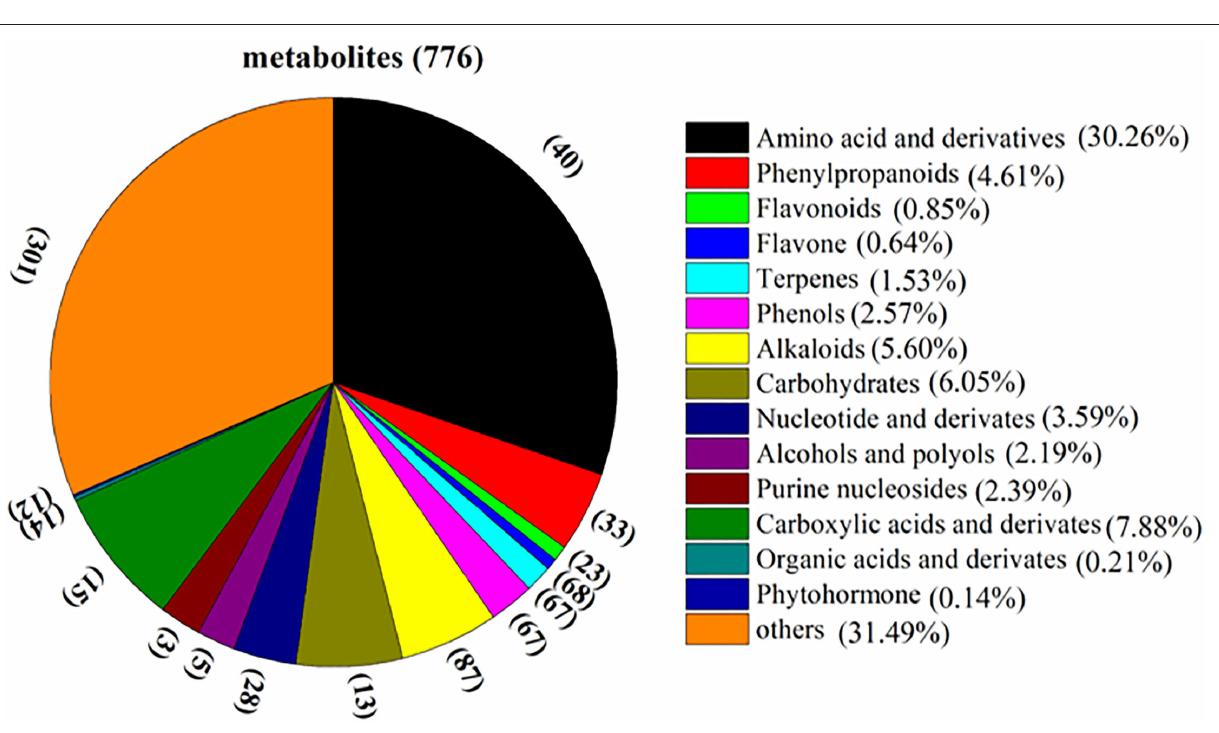
differentially expressed metabolites were classified into 21 classes, mainly amino acids and their derivatives, flavonoids and their derivatives, phenylpropanoids, alkaloids, terpenes, phenols, and nucleotide and their derivatives ( Table 1 ). In fresh vs. steamed group, it can be found that flavonoids (such as isoquercitrin, troxerutin, cyanidin, and fisetin), phenylpropanoids (such as chlorogenic acid and 3-(3,4-Dihydroxy-5-methoxy)-2-propenoic acid), and nucleotide and their derivatives (uracil and beta- Nicotinamide mononucleotide) were significantly DR, while